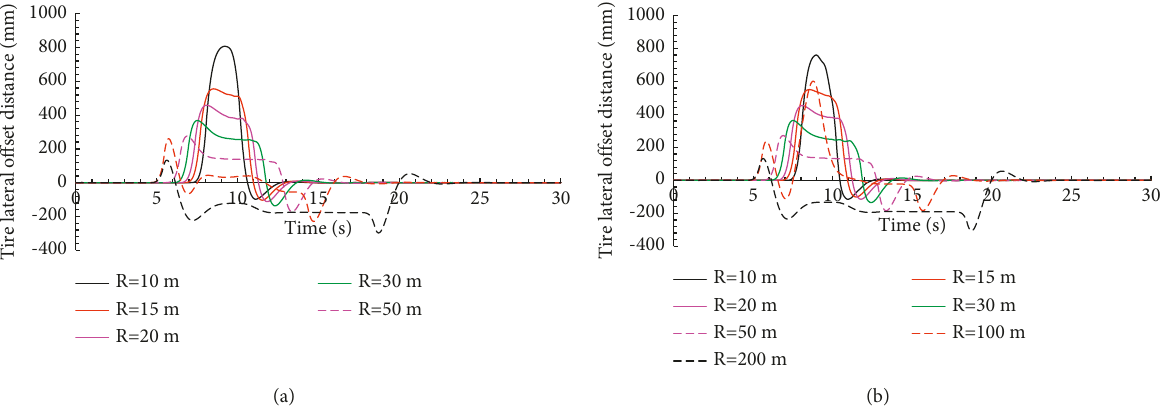
Figure 19: Tire lateral offset distance with different curve radius: (a) on dry road; (b) on wet